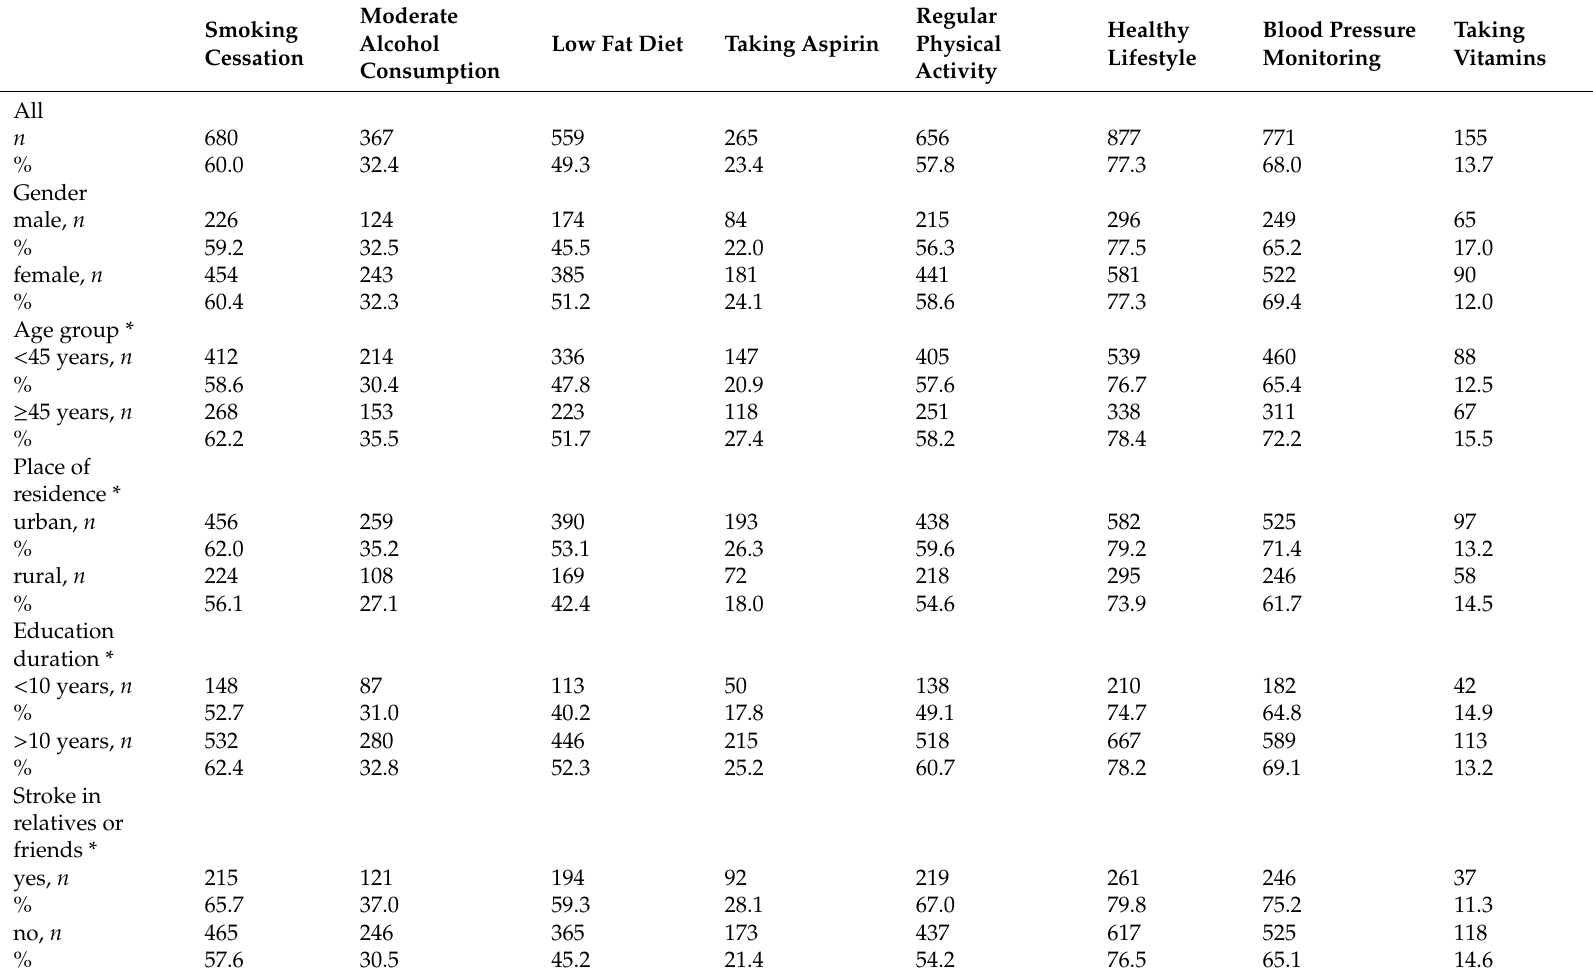
Table 5. Stroke prevention strategies indicated by participants in the response to close-ended question by gender, age group, place of residence, education level, and profession. Moderate Smoking Alcohol Low Fat Diet Taking Aspirin Cessation Consumption